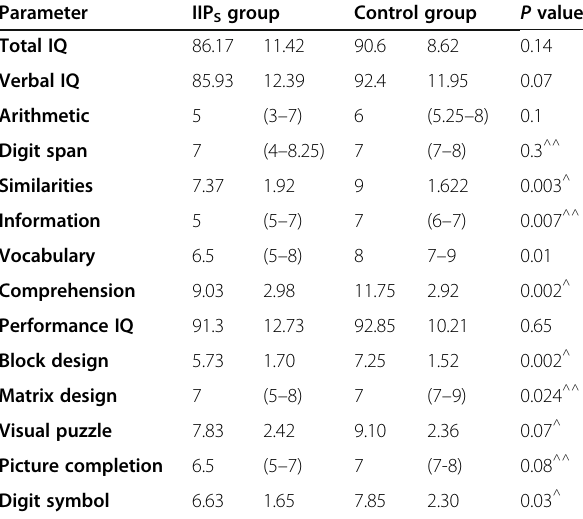
Table 3 Wechsler Adult Intelligent Scale (WAIS) in both groups Parameter IIP S group Control group